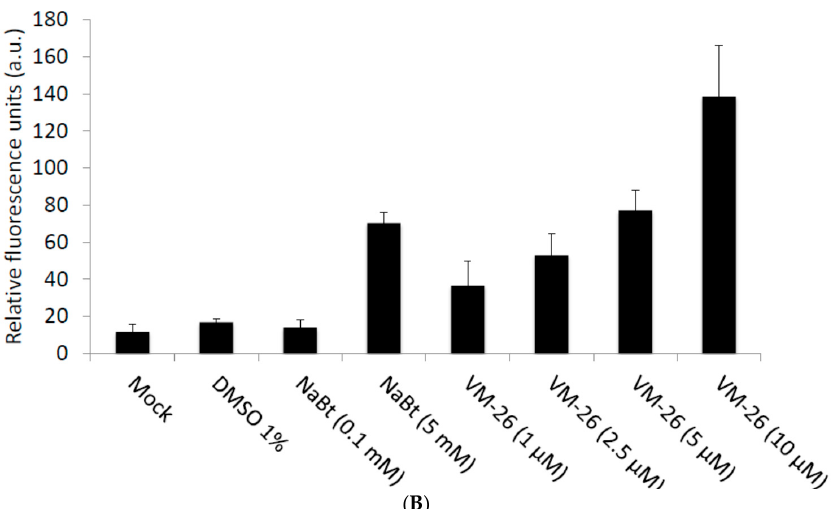
Figure 2. VM-26 can enhance BacMam transduction of U-2OS cells. ( A ) Representative images of U-2OS cells (5 × 10 4 cells seeded in a 24-well plate) transduced with vAc-CMV- α Syn·EGFP (moi = 100) and then concomitantly treated with NaBt or VM-26 at the indicated concentration for 24 h. A mock treatment or 1% DMSO was used as a control. Pictures were taken 24 h after transduction under a FITC channel with a 450/490-nm filter set using an exposure time of 1 s; the scale bar is 50 μ m; ( B ) Spectrofluorometric measurement of EGFP fluorescence from U-2OS cells transduced with vCMV- α Syn·EGFP after 24 h and treated with NaBt or VM-26 as indicated. EGFP fluorescence emission was excited at 488 nm and monitored at 507 nm. All of the data are presented as the mean ± SD of three independent experiments.